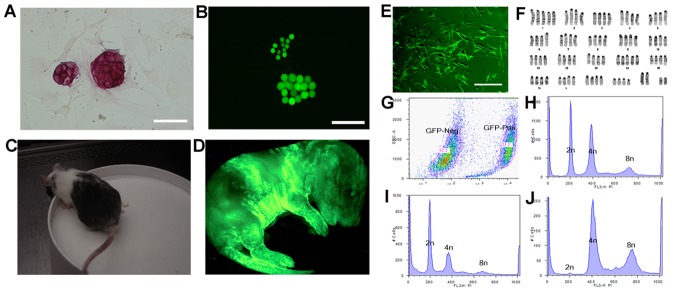
4nESCs are pluripotent and contribute substantially to chimeras.(A, B) 4nESCs express pluripotent markers, such as AP staining positive (A) and OCT4 expression (B). (C) A chimera (4n/2n) obtained by injection of 4nESCs (black coat color) into a 2n host blastocyst (white coat color). The chimera showed over 50% of 4nESCs contribution judging by the coat color. (D) A new born pup showed the contribution of 4nESCs (evidenced by the CMV promoter driven EGFP) in the 4n/2n chimera. (E) Fibroblasts from a newborn 4nESC/ICR chimera cultured in vitro, the derivatives of 4nESCs are EGFP+. (F) Karyotype of EGFP+ fibroblasts from chimera (4n = 82, (1, +1; 14, +1)). (G) Two populations of fibroblasts (EGFP− and EGFP+). (H) The DNA content of the total population of fibroblasts stained with PI shows three peaks: 2n, 4n and 8n. (I) The DNA content of sorted EGFP− fibroblasts shows two major peaks: 2n and 4n. (J) The DNA content of sorted GFP+ fibroblasts show two peaks: 4n and 8n. Scale bar: 200 µm.